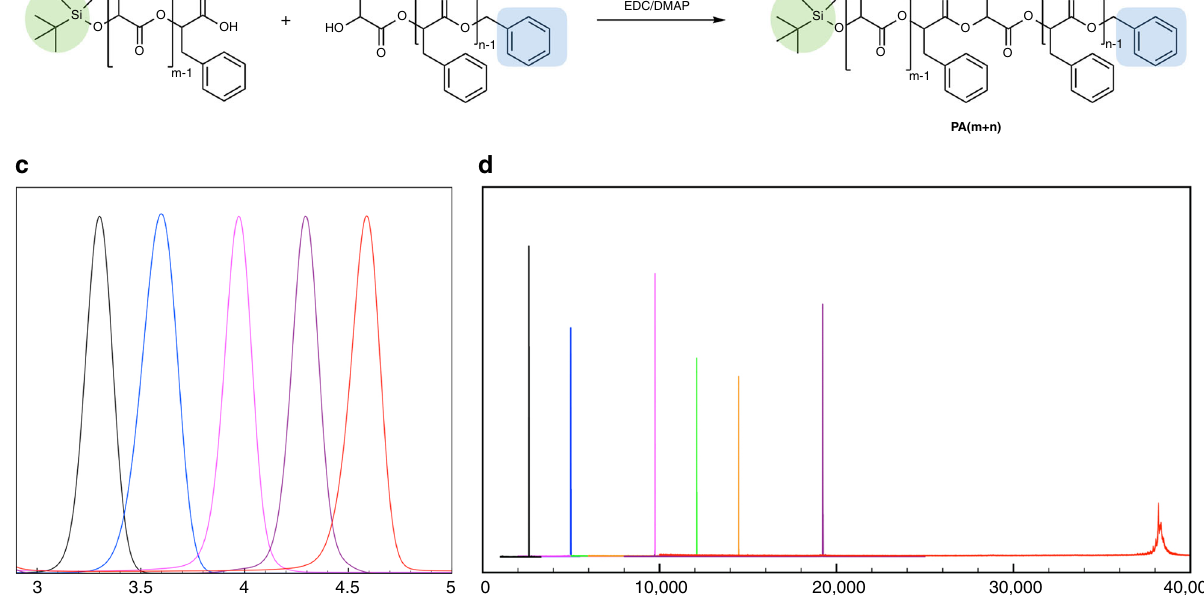
Fig. 5 Molecular-weight analysis of monodisperse PAHs. a The iterative convergent synthesis of poly( rac -phenyllactic acid) (PA n ). The deprotection and subsequent esteri fi cation reactions shown in the red dotted box constitute a convergent growth step. The number shown with circular arrows represent an iteration of the convergent growth step. b Method to obtain the monodisperse PAHs with desired number of repeating units via combination of constituent units. TBDMS and Bz protecting groups are highlighted in green and blue, respectively. c Gel-permeation chromatography of PAs with 16, 32, 64, 128, and 256 repeating units. d Combined MALDI-TOF mass spectra of PA16 (black, 2615.2 Da), PA32 (blue, 4986.4 Da), PA64 (magenta, 9728.4 Da), PA80 (green, 12100.7 Da), PA96 (orange, 14474.0 Da), PA128 (purple, 19220.6 Da), and PA256 (red, 38191 Da). MALDI-TOF MS of PA256 was measured in a linear mode. Other samples were measured in a re fl ection mode. The peak was assigned to a [M + Na] +